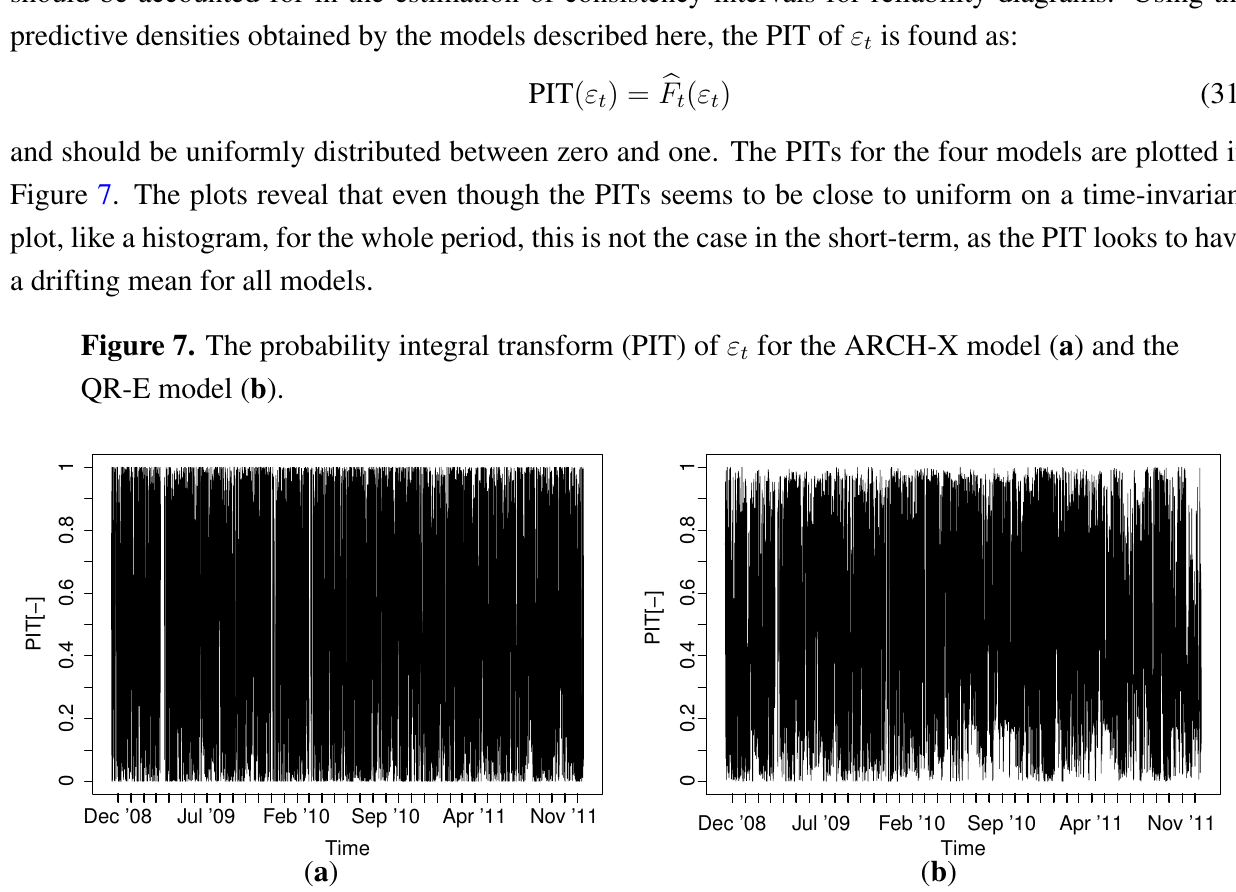
for the ARCH-X model ( a ) and the t